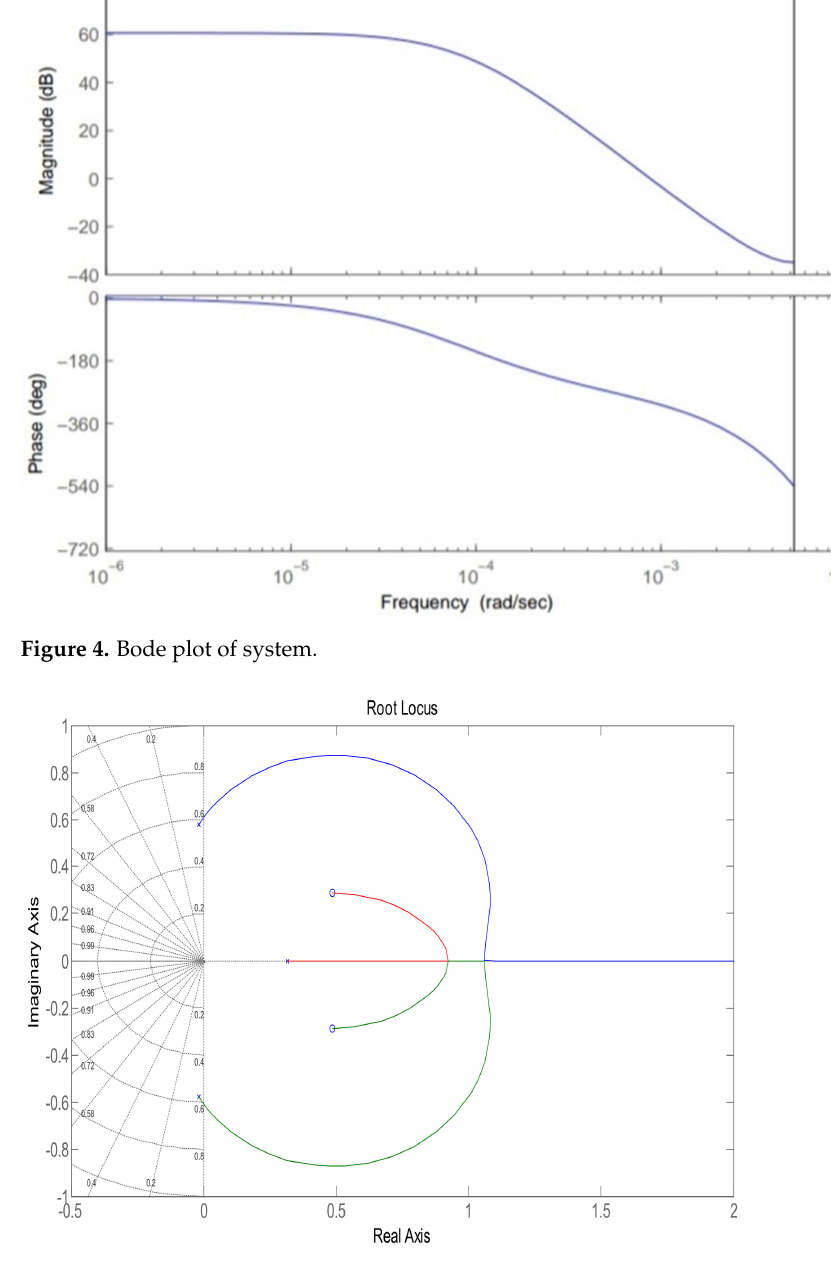
Figure 5. Root locus of